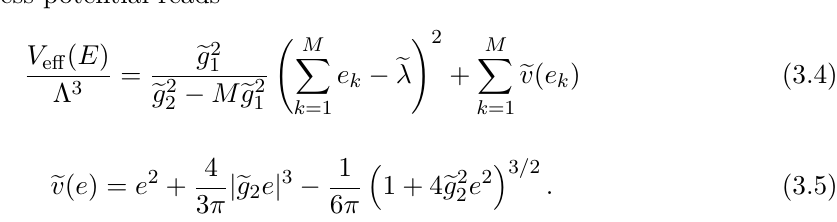
Figure 1 . The e λ -dependence of the minimum of V eff ( E ) for e k is represented by a different color. The plots are vertically displaced slightly so that they do not overlap